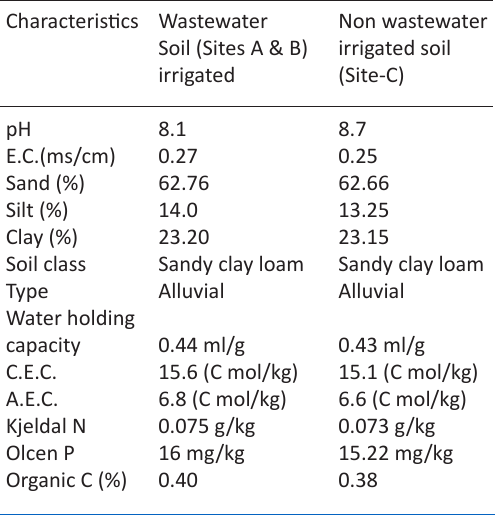
Table 1b. Physico-chemical characteristics of Aligarh